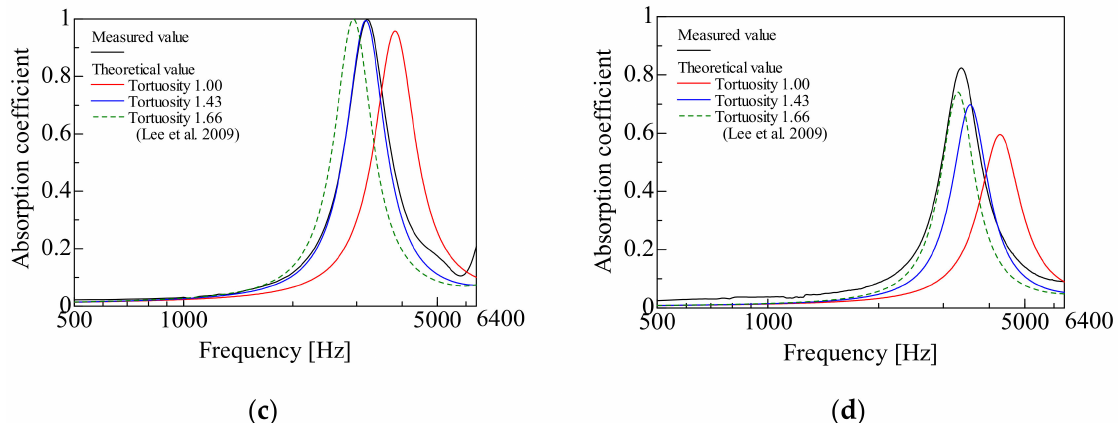
Figure 13. Comparison between the experimental and calculated values (considering tortuosity in Section 3.2 and tortuosity in Reference (Lee et al. 2009) [5]) of the peak frequency and the sound absorption coefficient: ( a ) Hexagonal close-packed lattice ( d = 4 mm); ( b ) Hexagonal close-packed lattice ( d = 8 mm); ( c ) Face-centered cubic lattice ( d = 4 mm); and ( d ) Face-centered cubic lattice ( d = 8